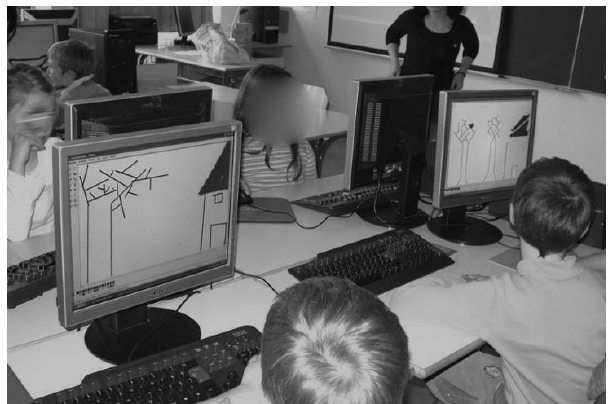
Figure 1. Possibilities of using ICT in the process of learning visual art in class for drawing.